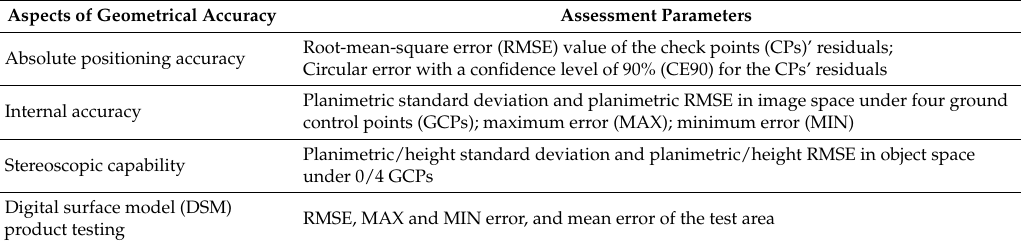
Table 5. Parameters associated with different aspects of the geometrical accuracy to be